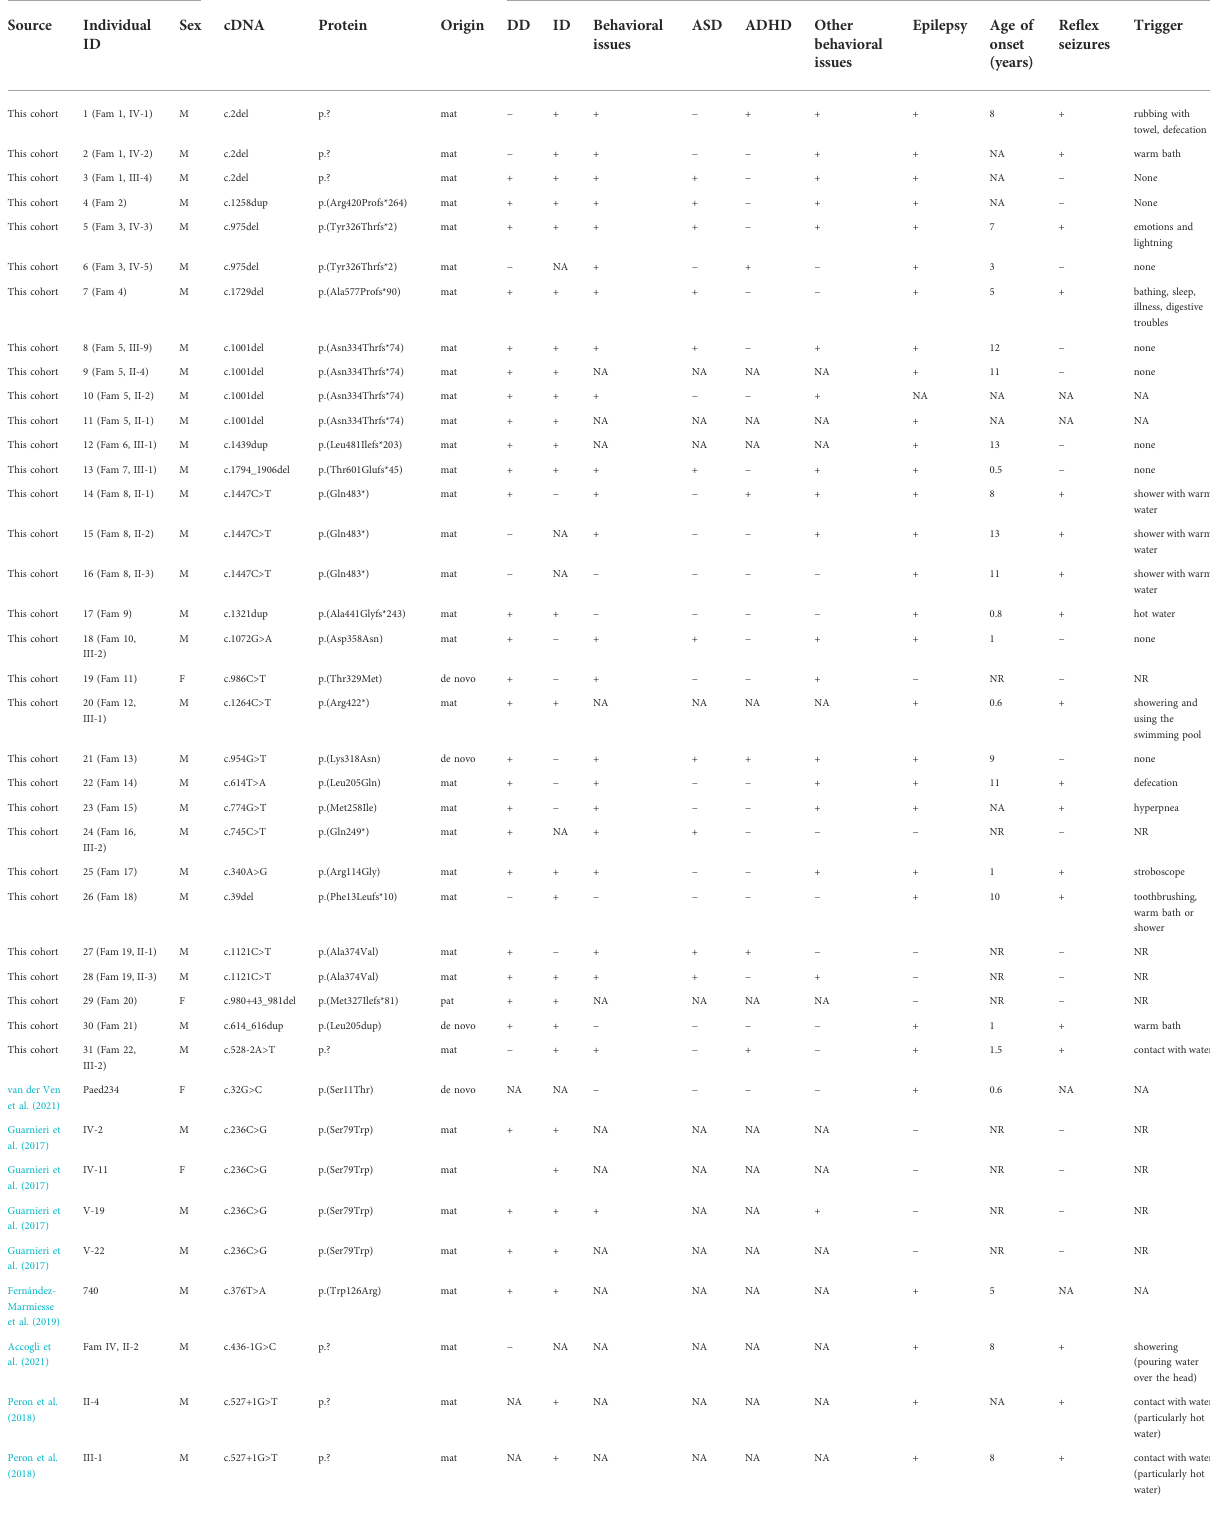
TABLE 1 Main clinical features of individuals with SYN1 variants.